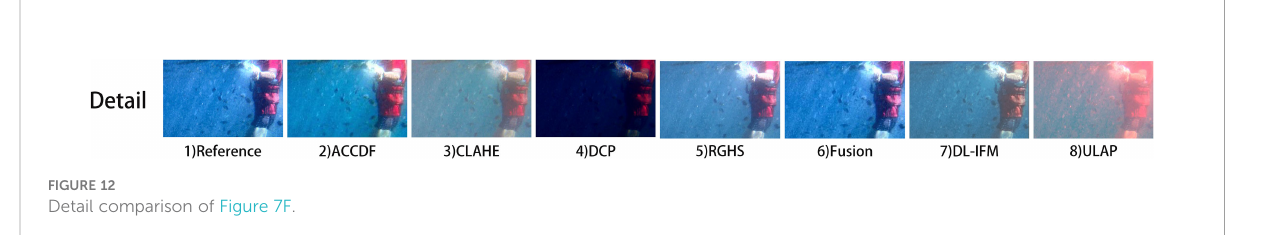
FIGURE 12 Detail comparison of Figure 7F.